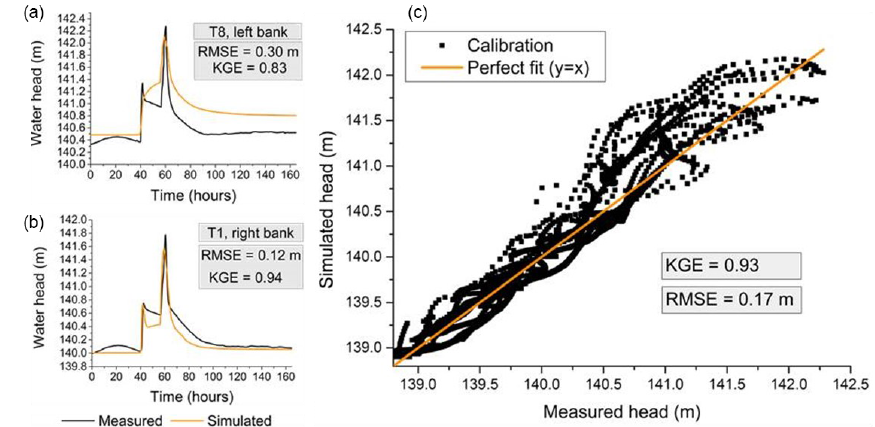
Figure 5. Comparison between simulated and measured hydraulic heads in the subsurface during the calibration period. (a, b) Evolution over time at the two transects, that is, the worst (a) and best (b) transects regarding RMSE. (c) Local in space and time values of simulated hydraulic heads as a function of observed ones. RMSE is the root mean square error, and KGE is the Kling–Gupta